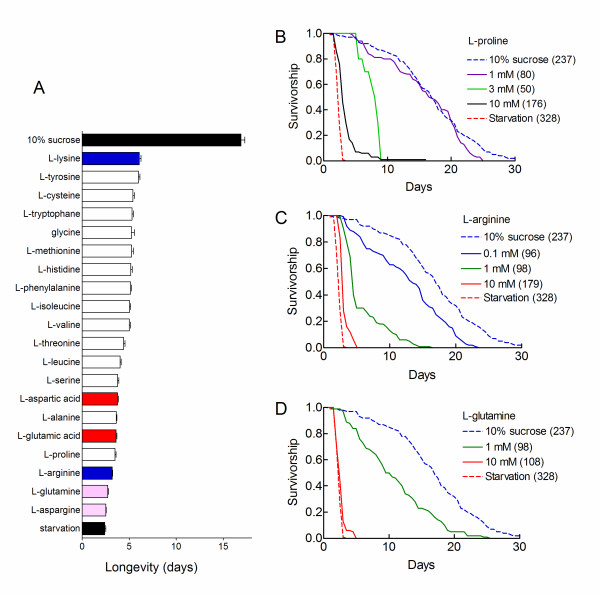
Natural amino acids reduce the longevity of chronically hypoxic flies. A. Flies were fed on a 10% sucrose diet supplemented with each individual amino acid (10 mM) and survivorship curves were determined under chronic hypoxic conditions. Mean longevities ± sem are shown. Amino acids are ranked according to their life-shortening effect. The top and bottom black bars show the two control situations which correspond to a pure sucrose diet and starvation conditions. All differences with the pure sucrose condition were statistically significant (p < 0.0001, log rank test). Colour codes were used to label basic amino acids (blue), acidic amino acids (magenta) and amidinated amino acids (red). The total number of flies used was 2341. Sample sizes were 70–237. B-D. Dose dependent actions of L-proline, L-arginine and L-glutamine. Hypoxic flies were fed on a 10% sucrose medium supplemented with the indicated concentrations of amino acids and survivorship curves were determined. The dotted lines show the survivorship curves obtained for hypoxic flies fed on a pure sucrose diet (blue) or under starvation conditions (red). Sample sizes are indicated in parentheses. Note that low mM concentrations of amino acids produced near half maximum reductions in the median and maximum longevities of the flies.